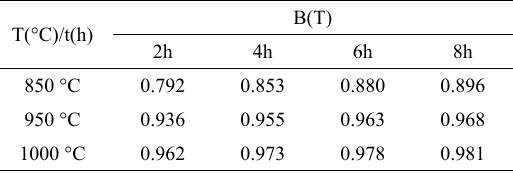
Figure 3. Incubation time according to the temperature for 2h. Table 4. Simulated values of the parameter B (T) according to temperature.